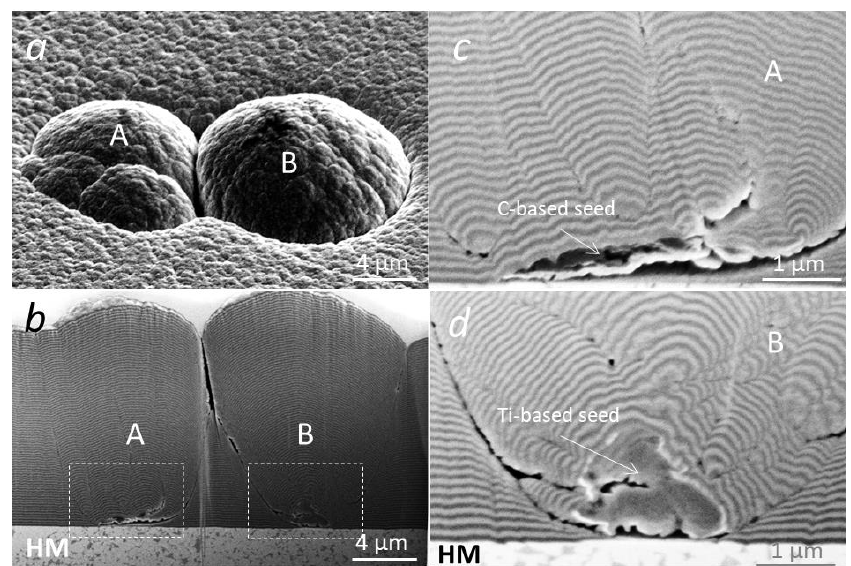
Figure 13. Top view SEM image ( a ) and SEM images of FIB cross-sections ( b ) of the nodular defects in the NL-TiAlN/CrN coating. The left nodular defect formed at the site of a carbon-based particle ( c ), while the right one was at a titanium-based particle ( d ). A small step on the substrate surface beneath the titanium-based particle proves that it arrived on the substrate surface during the ion etching process.